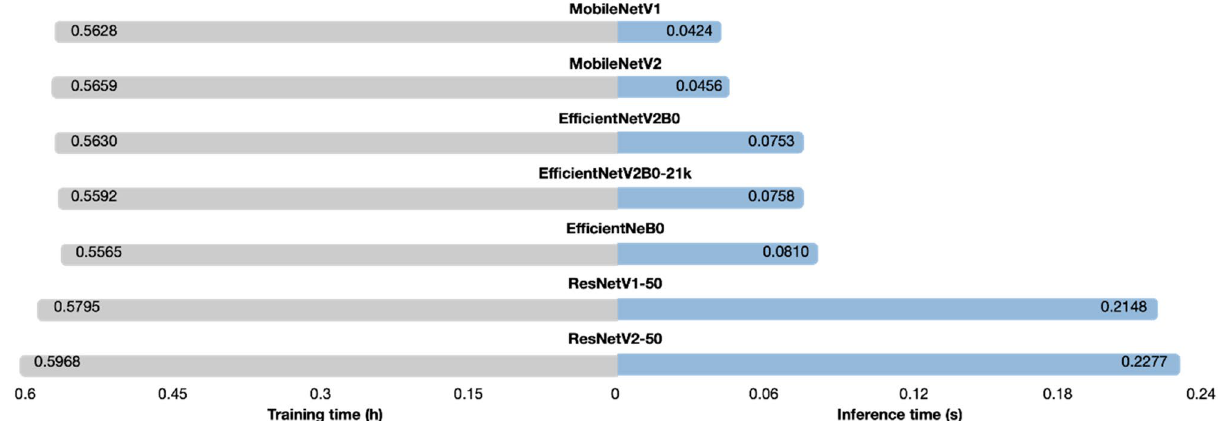
Figure 7. This bar chart depicts the inference time (seconds) and training time (hours) for seven CNN models trained on the FBCG dataset using the fivefold stratified CV (a low inference time indicates that the CNN model can predict the result in a short period; a low training time indicates that the CNN model can be trained in a short period). The majority of CNN models (with the exception of ResNetV1-50 and ResNetV2-50) can predict outputs in less than 0.1 s. MobileNetV1 predicts outputs the fastest (inference time = 0.0424 s), while ResNetV2-50 predicts outputs the slowest (inference time = 0.2277 s). All selected CNN models can be trained in 0.6